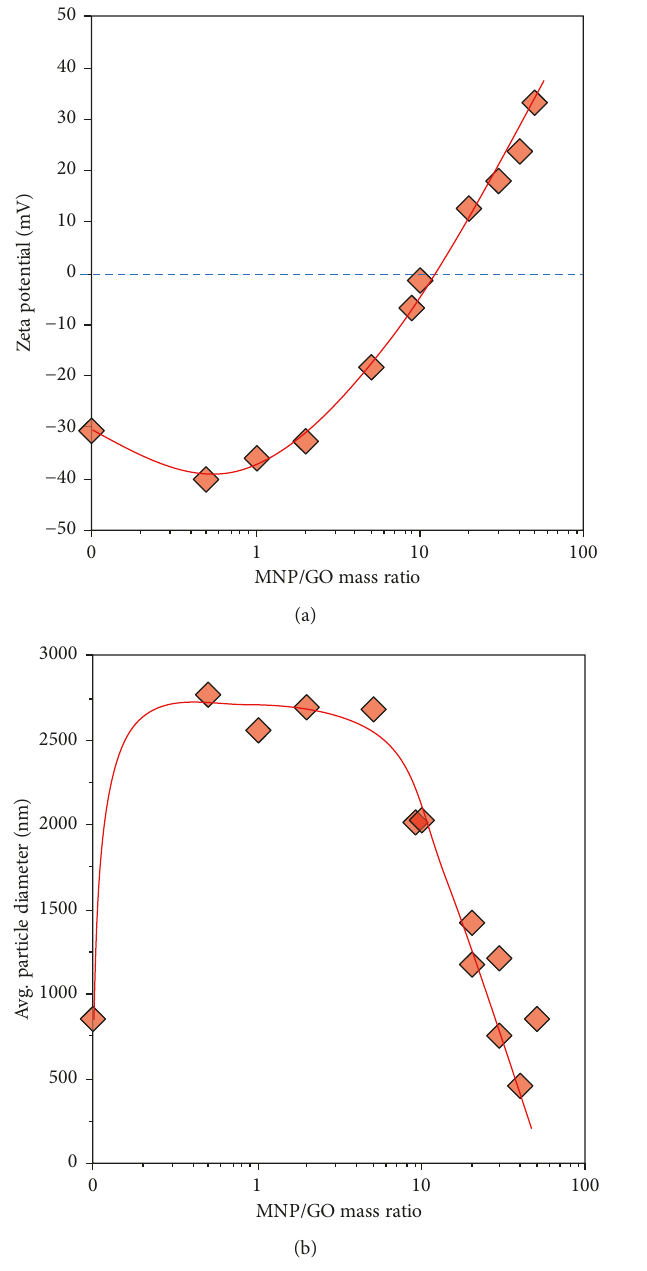
Figure 8: Electrokinetic potentials (a) and Z-average particle di- ameters (b) of the MNP/GO nanocomposite aqueous dispersions as a function of the MNP/GO mass ratio. Measurements refer to the pH range of 4.5–6.